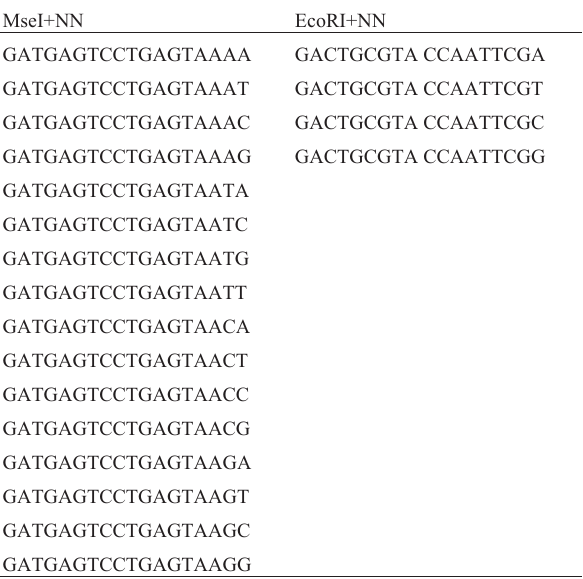
Table S1 - Sequences of the primers used for